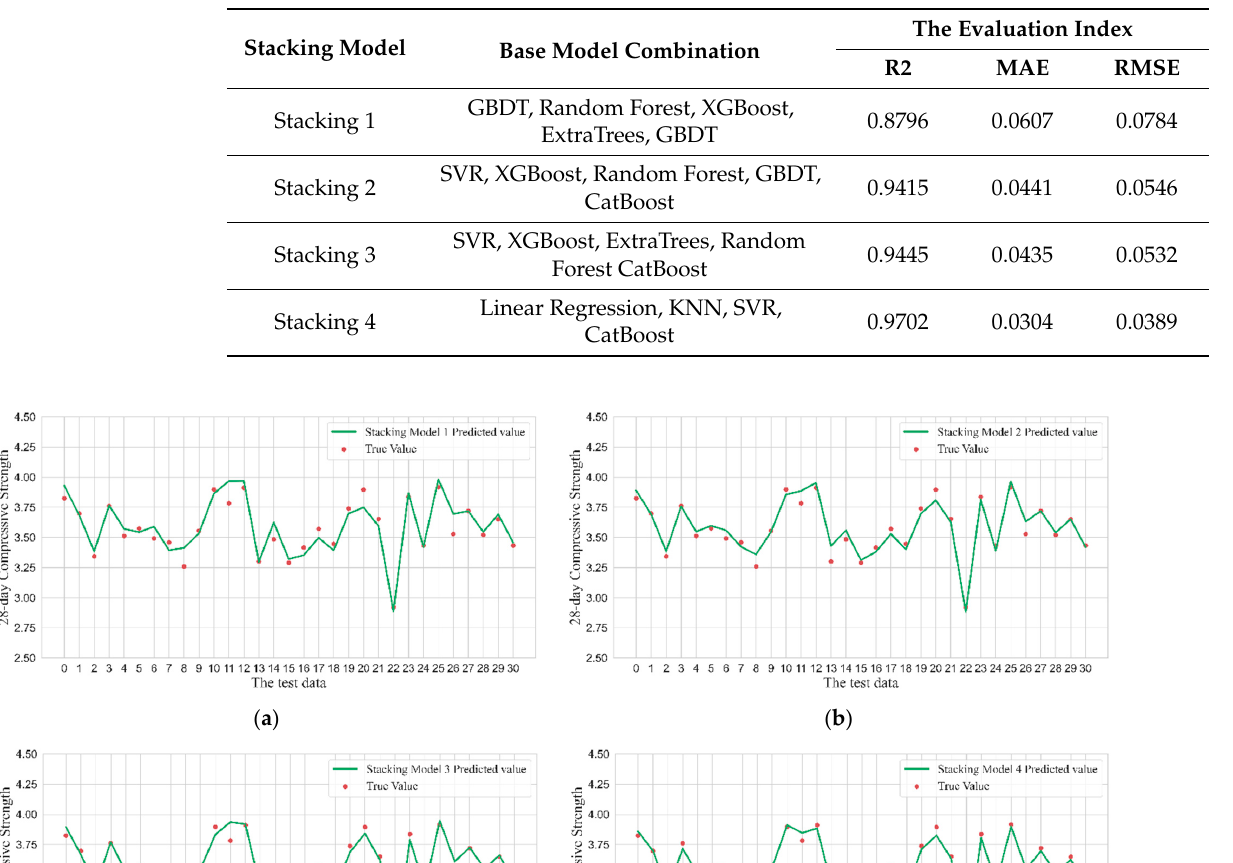
Table 10. Prediction results of different stacking models.